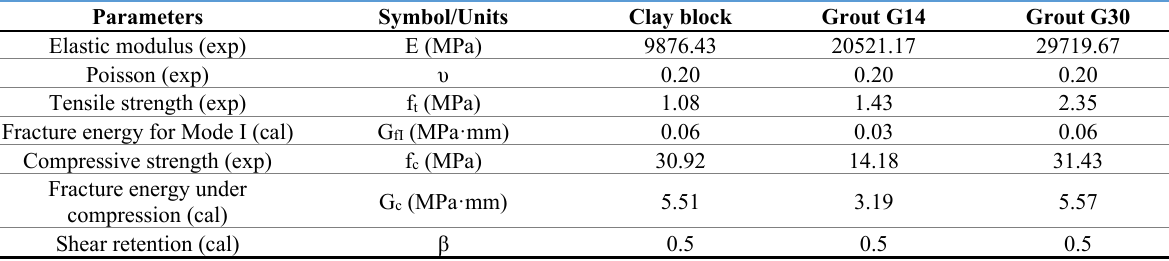
Table 7. Mechanical properties of the Total Strain Crack Model (masonry units and grout).